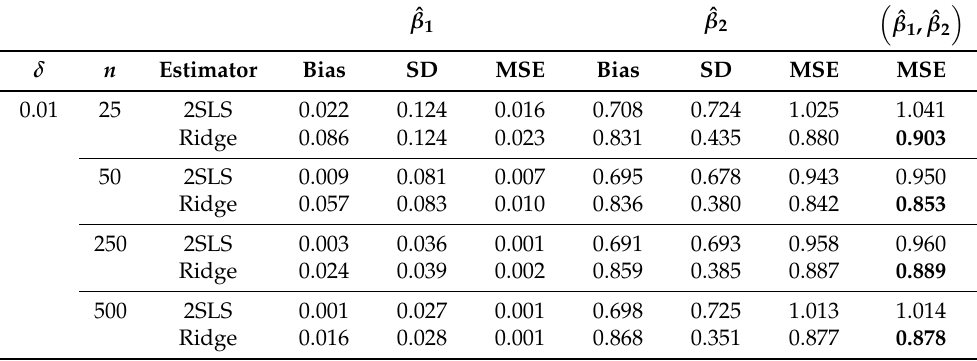
Table A4. The simulated model is given by Equations (1), (2), (4) and (12) with k = 2, m = 4, z i ∼ iid N ( 0, I 4 ) , and β 0 = ( 0,0 ) (cid:48) . Summary statistics are reported for estimates of ˆ β 1 and ˆ β 2 using the 2SLS and ridge estimator for β p = ( 1,1 ) (cid:48) , where τ = 0.5. The models differ with respect to the strength of the instrument ( δ ) and sample size ( n ). Each model is simulated 10,000 times. The ridge estimator outperforms the 2SLS estimator in terms of MSE values in a number of cases. In particular, in small samples and low precision settings, the ridge estimator leads to smaller MSE